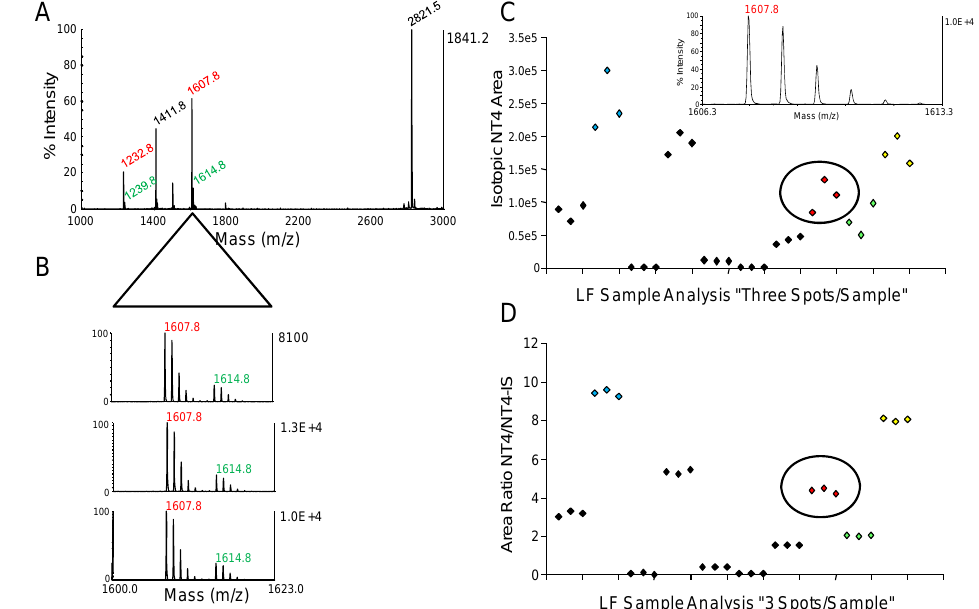
Figure 4. Isotope dilution for MALDI-TOF MS. Isotopically labeled internal standard peptides NT4-IS and CT4-IS, 7 mass units higher than the NT4 and CT4 peptide products are added to the sample and mixed in the MALDI chemical matrix CHCA as described previously [7]. A full spectrum is shown for a sample from an experimental rhesus macaque infection (A). The m/z range is narrowed for spectra from three spots of the same sample showing the CT4 LF cleaved product and the CT4-IS isotopic peaks and shows the variation in peak intensity from 8,092, 10,000 and 13,000 for the three spots (B). The CT4 peak areas alone were plotted for 10 archived samples from rhesus macaque anthrax inhalation infections and show the variation in area for triplet peaks from the same sample (C). The area ratios, area of CT4 divided by the area of CT4-IS, were plotted for the same 10 samples in C and shows how the variation was normalized (D). The areas and area ratios of the three spots in B were circled in C and D,